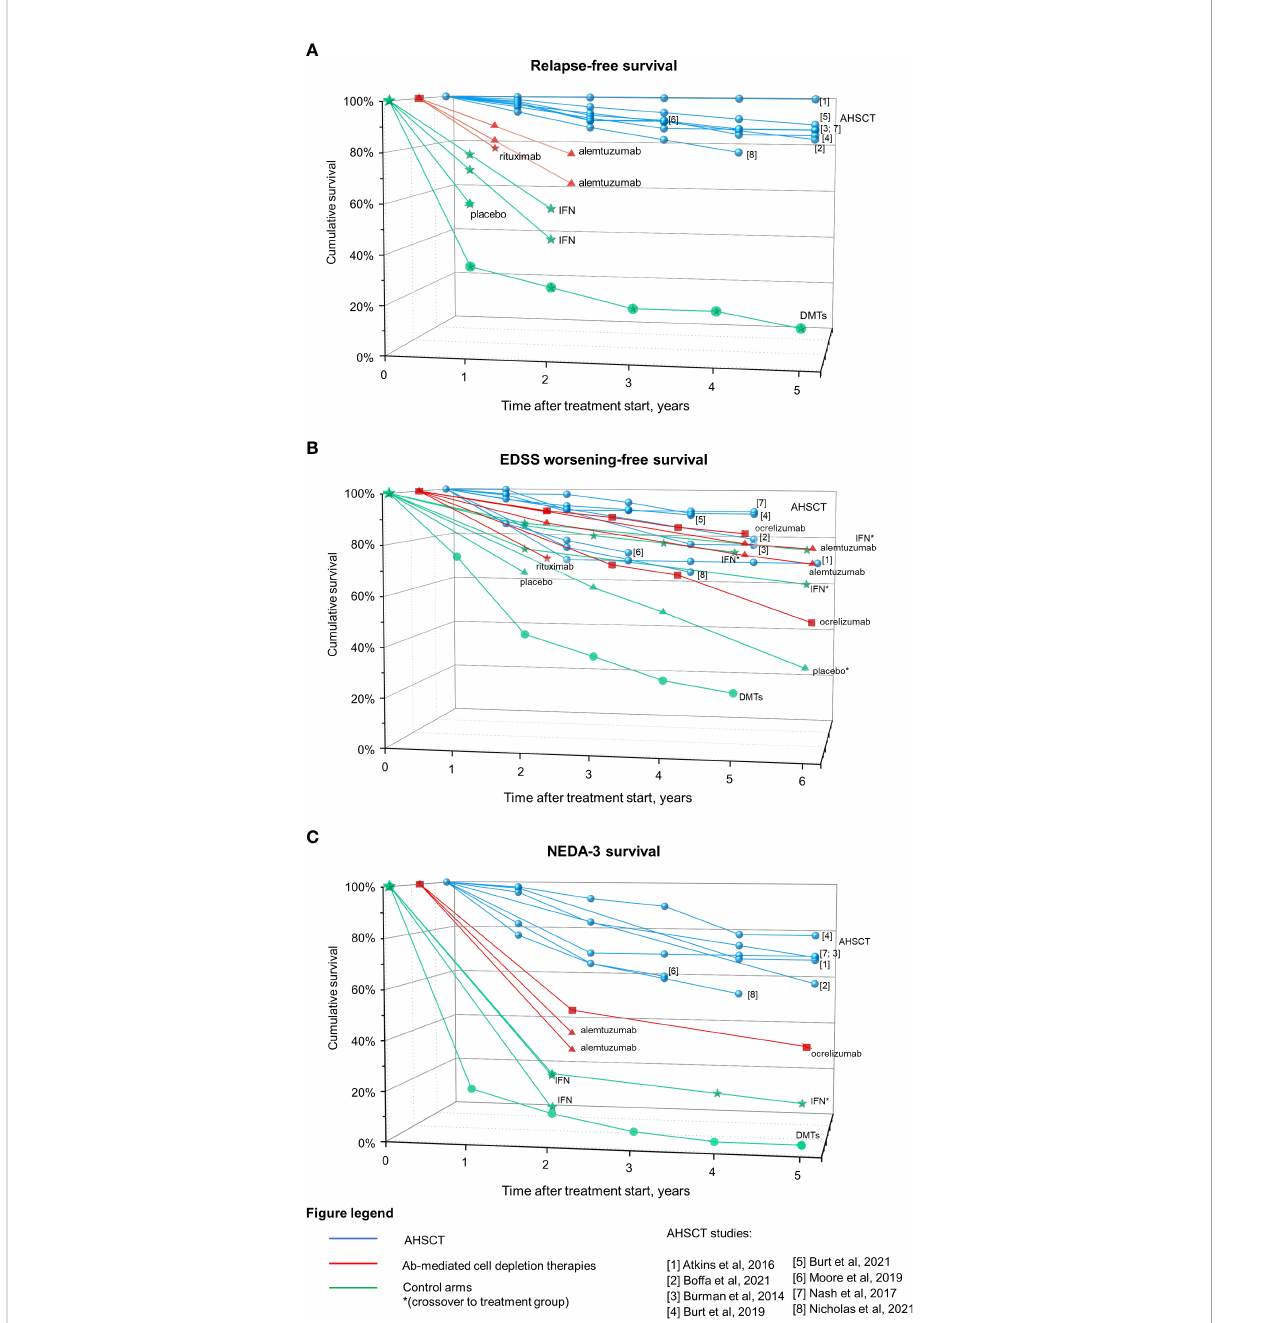
FIGURE 3 Ef fi cacy on Ab-mediated cell depletion therapies and AHSCT on clinical and radiological measures of disease activity in MS. Data derived from AHSCT studies (blue), treatment arm of RCTs on Ab-mediated cell depletion therapies (red) and corresponding control arms (green) are reported as cumulative rates of survival free from relapses (A) , EDSS worsening (B) , and combined clinical-radiological disease activity (NEDA-3, (C) . Patients originally randomized to the control arm who were switched to the treatment under investigation during the OLE phase are marked with *. The control arm of the MIST trial on AHSCT is also depicted (DMTs), including patients who had failed DMTs prior to inclusion and received DMTs of higher ef fi cacy or a different class than the therapy they were taking at the time of randomization. Differences in the characteristics of the patient populations included across trials (such as the selection of patients with highly active disease while on treatment and the lack of escalation in a subset of the cases for the DMTs group) could explain, at least in part, the fact that the DMTs group from the MIST trial performed lower than the placebo group of other